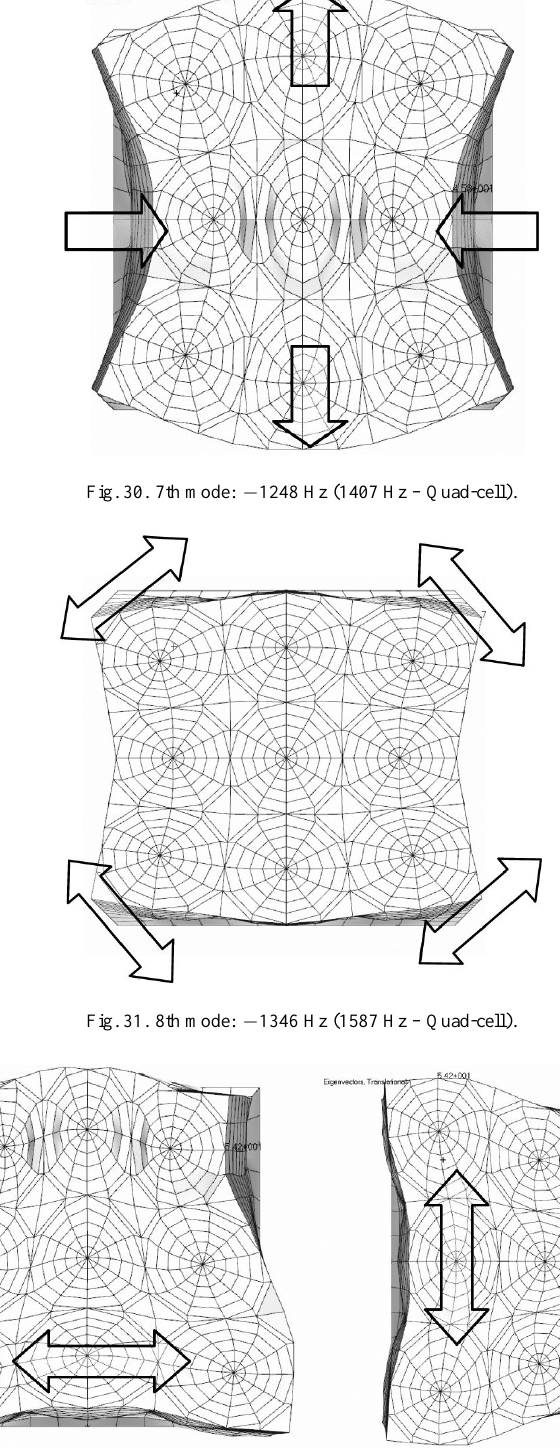
Fig. 32. 9th (left) and 10th (right) mode: − 1395